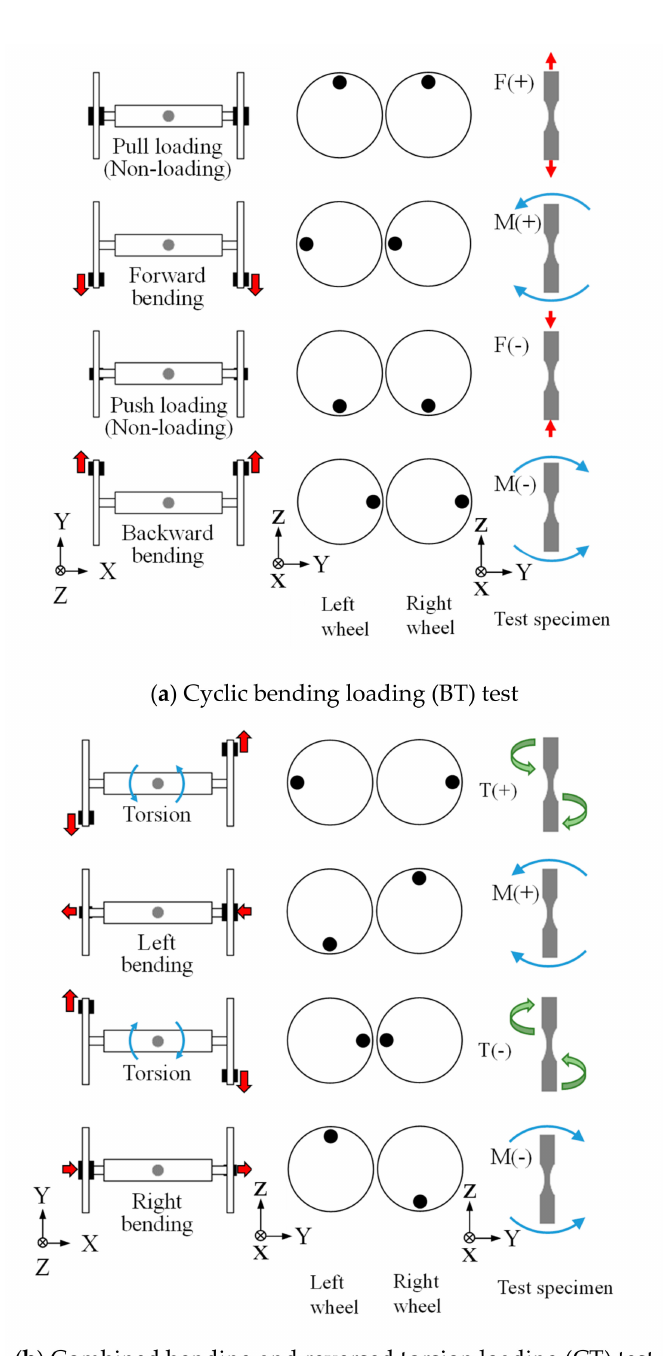
Figure 4. Weight settings for bending and combination loading